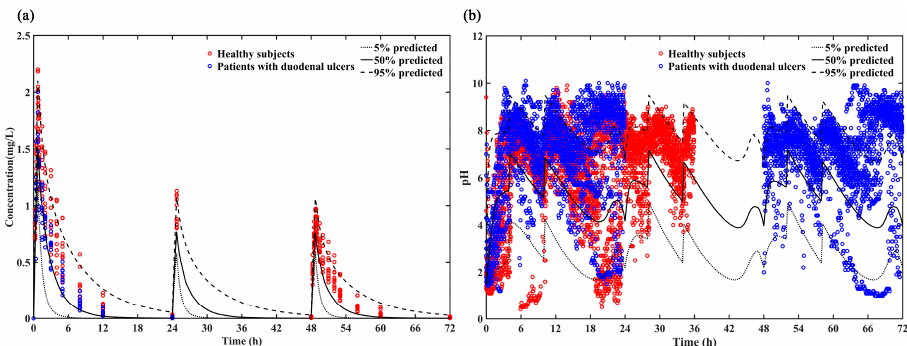
Figure 4. ( a ) Predicted PK profile (5%, 50% and 95% quantiles) vs. Observations of loading dose for healthy subjects